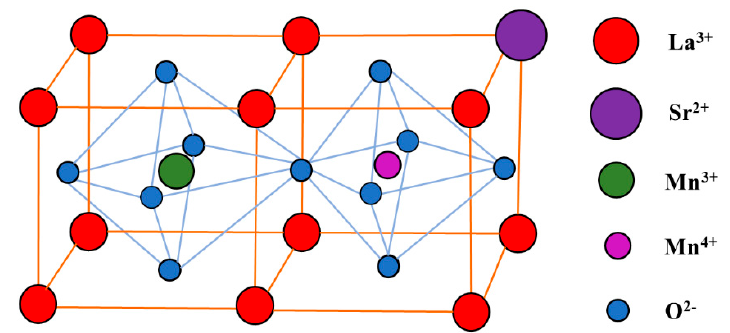
Figure 1. Structure of La 0.8 Sr 0.2 MnO 3